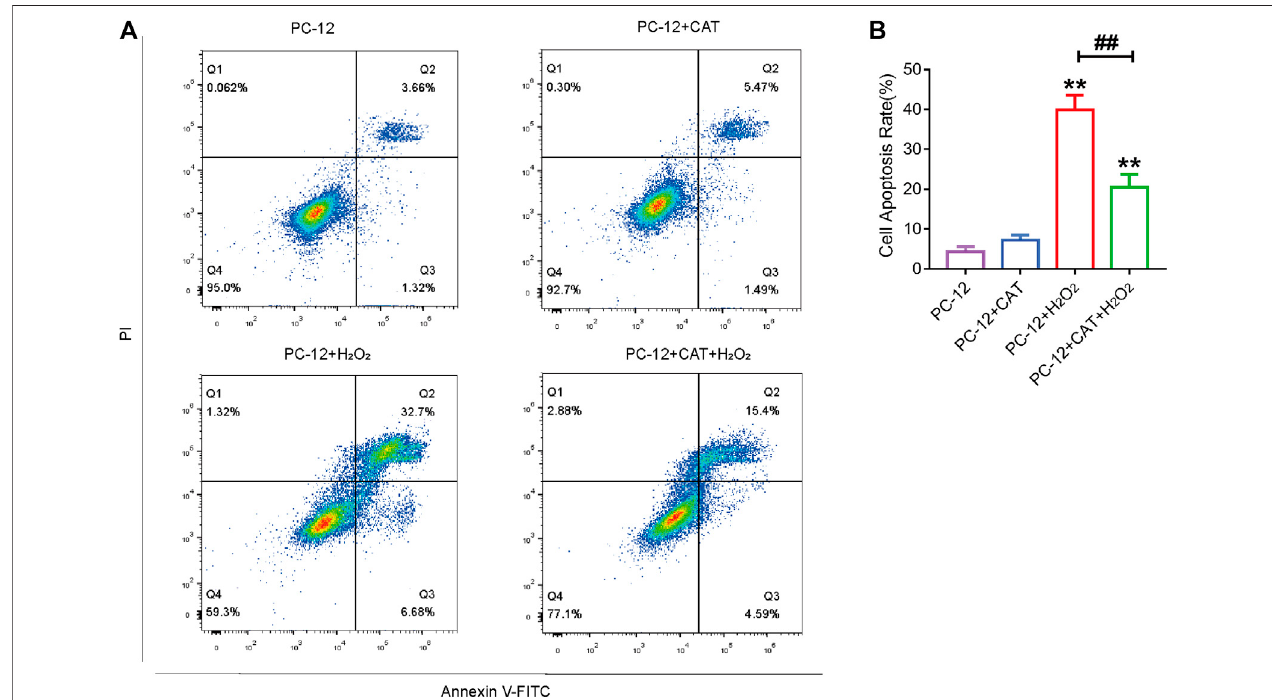
FIGURE 7 | CAT treatment reduces hydrogen peroxide-induced apoptosis in PC-12 cells. (A) Annexin V-FITC/PI staining for cell apoptosis analysis. (B) Statistical resultofapoptosisrateinPC-12group,PC-12 + CATgroup,PC-12 + H 2 O 2 group,andPC-12 + CA+ H 2 O 2 group.Student ’ sttestwasusedtoanalyze fl owcytometry results. “ * ” represents p < 0.05, “ ** ” represents p < 0.01 versus the PC-12 group. “ ## ” represents p < 0.01 comparing the PC-12 + H 2 O 2 group to the PC- 12 + H 2 O 2 + CAT group with statistical signi fi cance. Data are represented as mean ± SD ( n = 3).